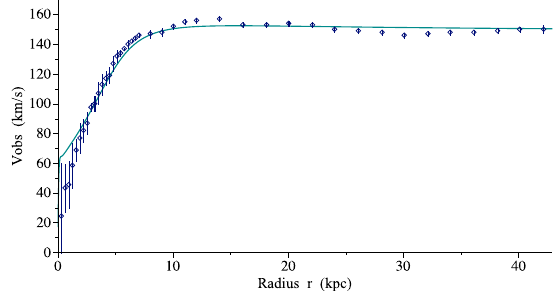
Figure 12. NGC3198—Type SAc, SBbulge ( r ) = 0, ( α , β ) = ( 4.1923,1.4546 )